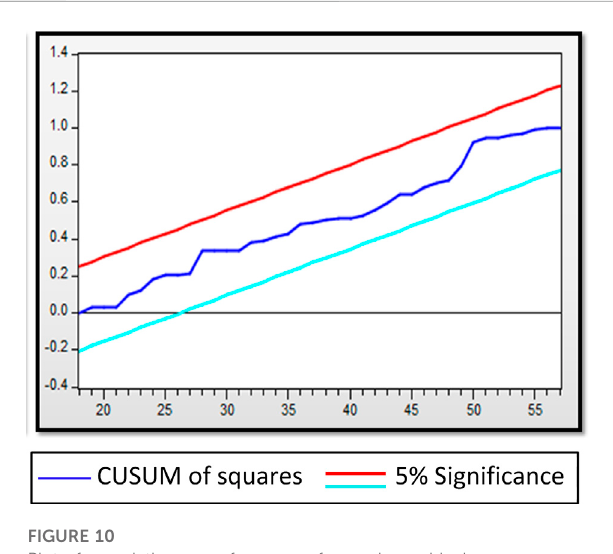
FIGURE 9 Plot of cumulative sum of recursive residuals (CUSUM).